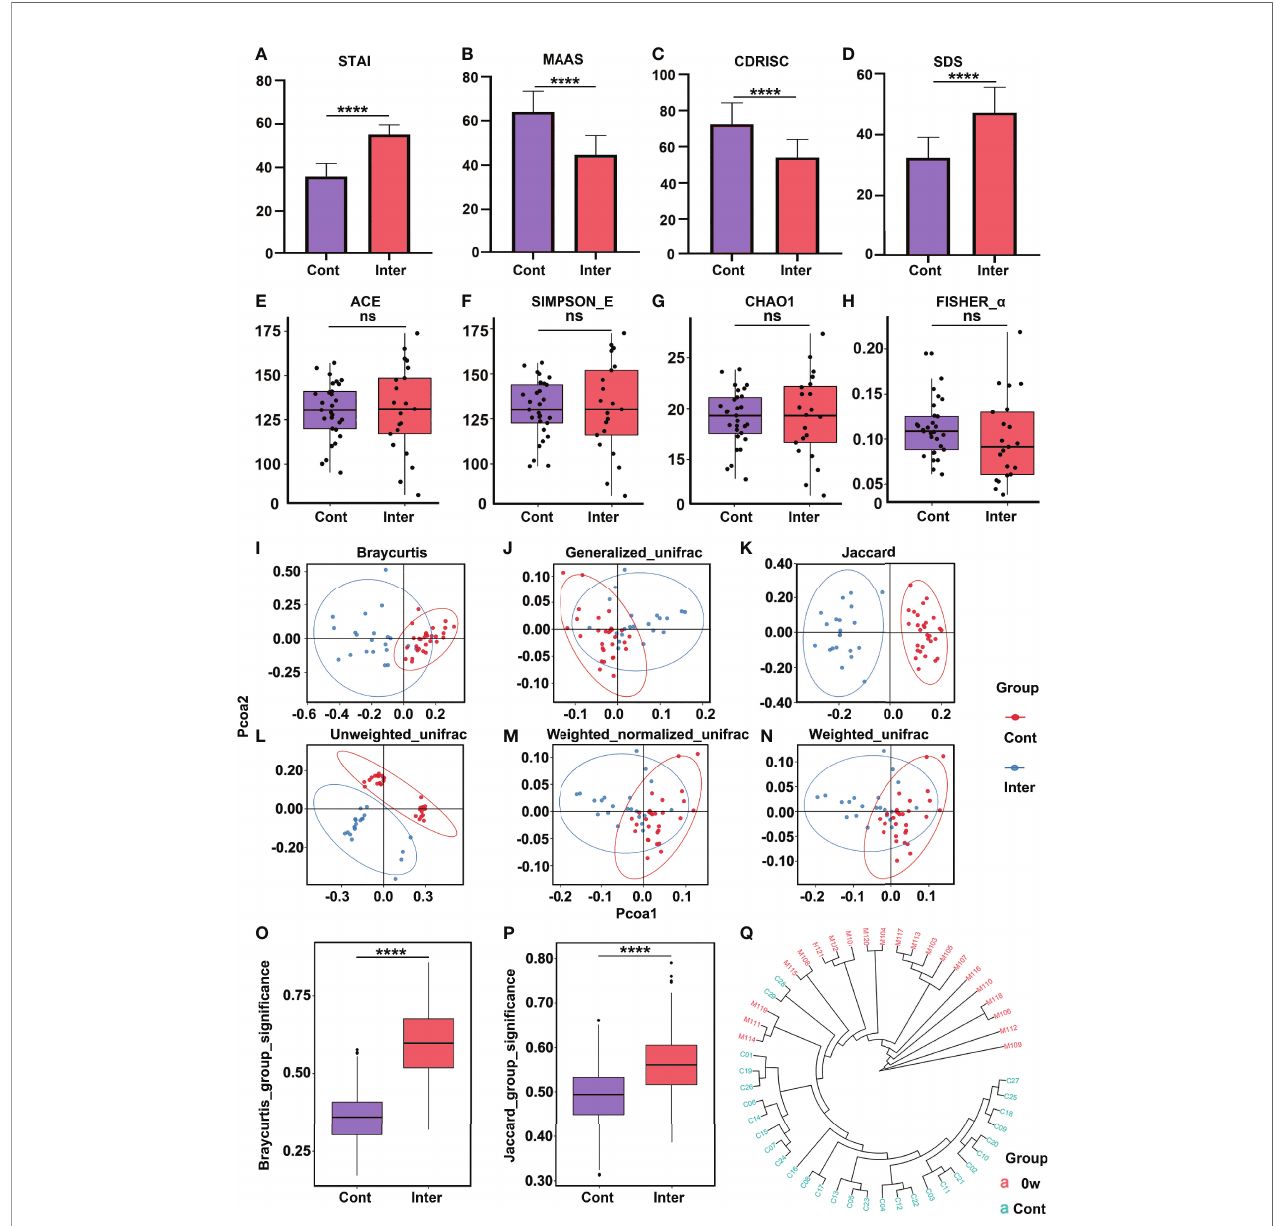
FIGURE 1 | Comparison of psychometric indicators, diversity indices, and PCoA between the intervention group (high trait anxiety) and control group. The mean scores were compared on the scales of STAI (A) , MAAS (B) , CD-RISC (C) , and SDS (D) . The a -diversity indices included Ace Index (E) , Simpson_E Index (F) , Chao1 (G) , and Fisher_ a (H) . The b -diversity indices were illustrated by different algorithms (I – N) . Clustering of fecal bacterial communities according to PCoA analysis by different algorithms: the distance indices (O, P) and cluster tree (Q) . **** means p value < 0.0001; NS means not signi fi